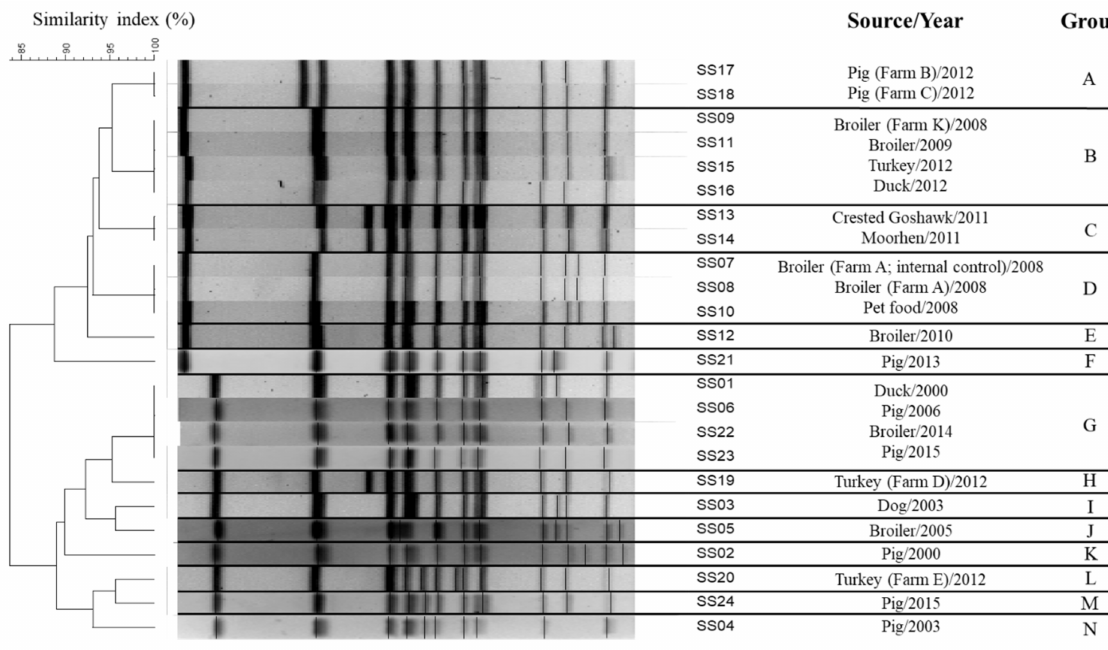
Figure 1. PFGE profiles of 24 S. enterica serovar S. Schwarzengrund isolates (14 profiles; DI =